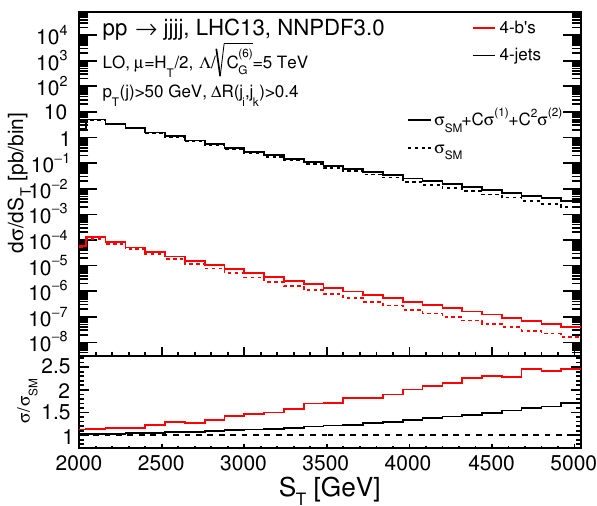
Figure 11 . Comparison of the S T = (cid:26)(cid:26) E T + P N jets production (red) and four-jet production (black).